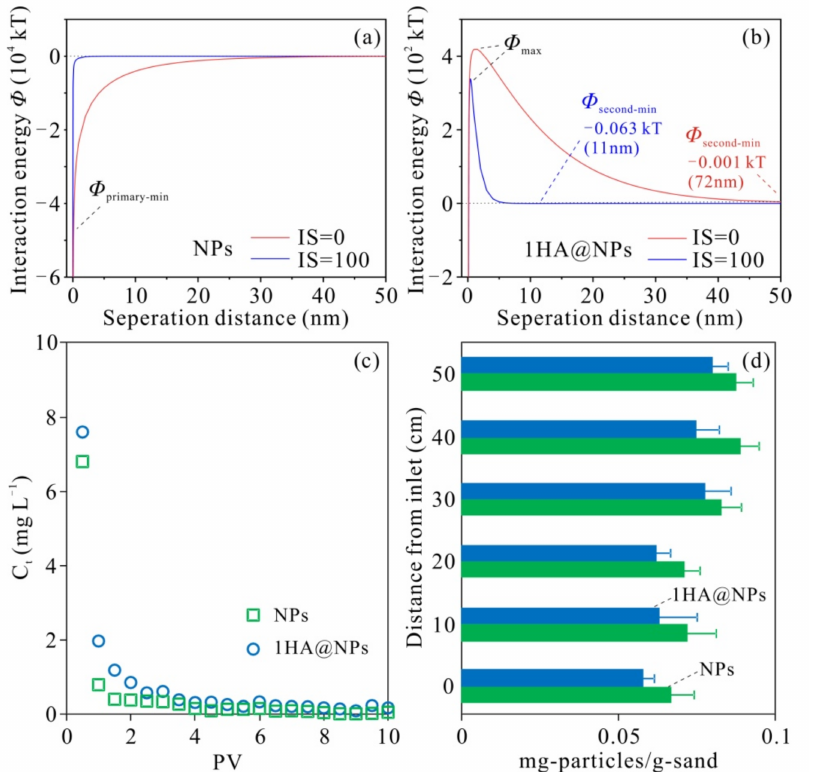
Figure 3. Calculated DLVO interaction energy plotted as a function of separation distance between the sand surface and NPs ( a ) or 1HA@NPs ( b ) surface at IS = 0 mM and 100 mM. Release of NPs and 1HA@NPs from the column during sequential elution experiment ( c ) and retention profiles of the two particles after 10 pore volumes (PVs) elution finished ( d ) (IS = 0